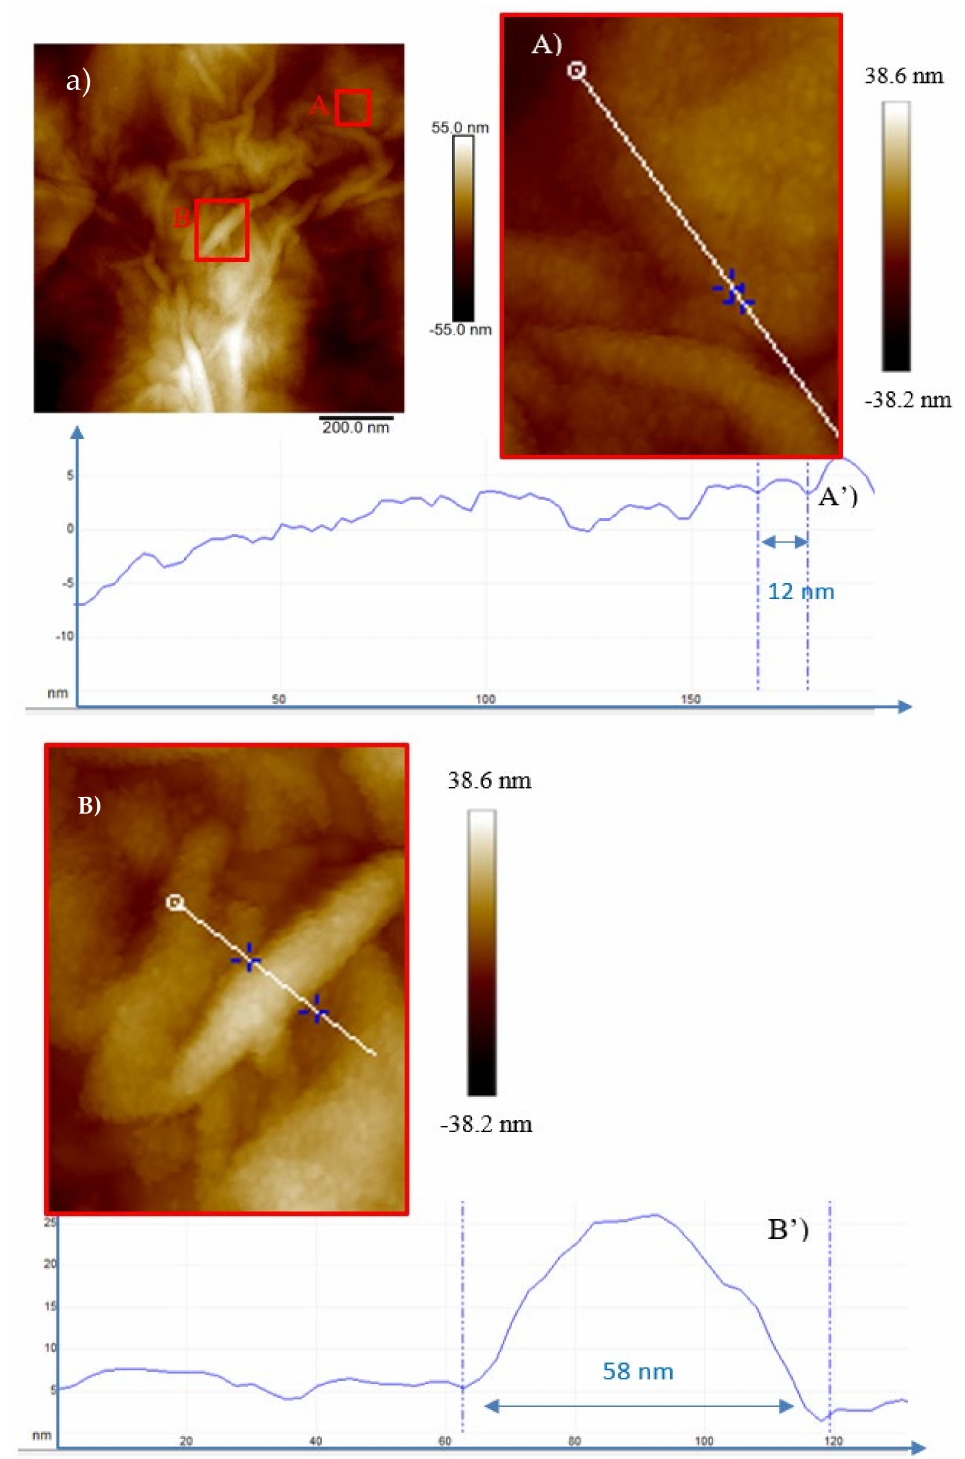
Figure 9. Two-dimensional AFM images of GO irradiated by the 3 MeV O + ions at the 5 × 10 13 ions/cm 2 ( a ), magnified area of the red square ( A ) profile of the selected structure ( A’ ) and magnified area of the red square ( B ) and profile of the selected structure ( B’